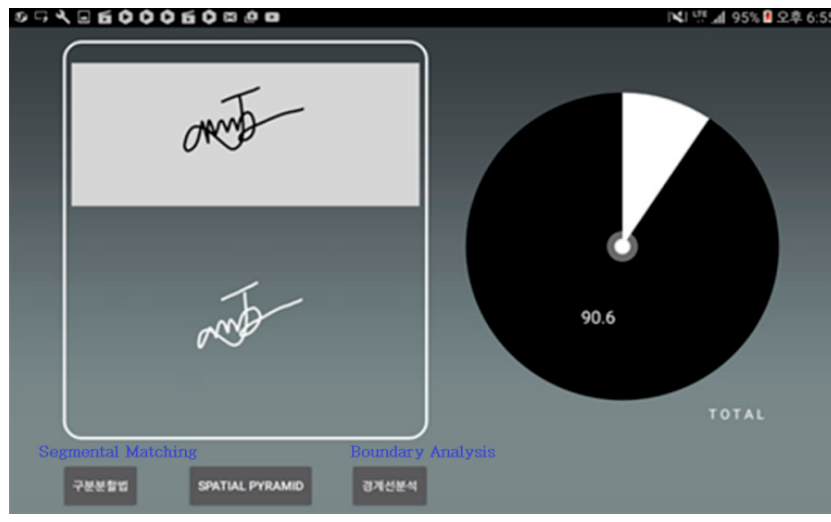
Figure 10. Final comparison screen.